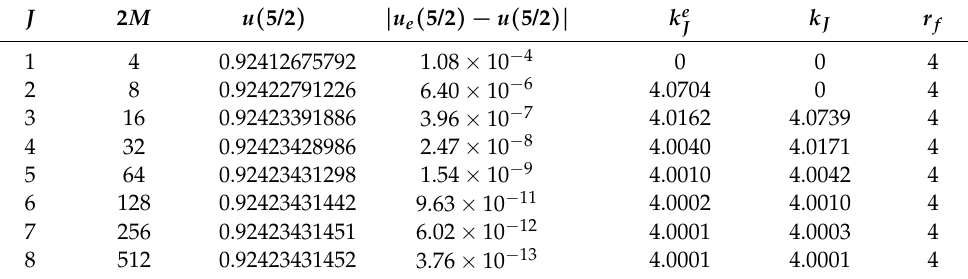
Table 8. Solutions to (24) where u e ( 1/2 ) = 0.9242343145 using HOHWM.